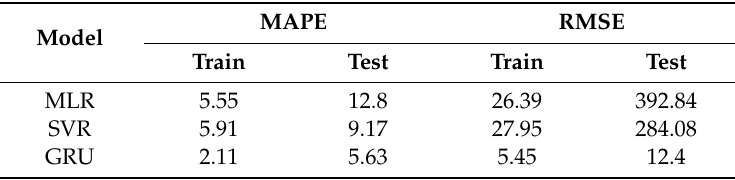
Table 2. Comparison of forecasting error for various models.